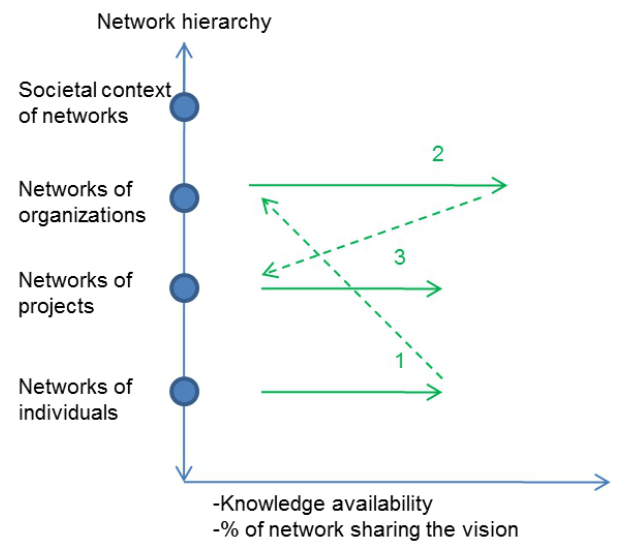
Fig. 6 . Knowledge availability and the spreading of a vision set against different network levels.